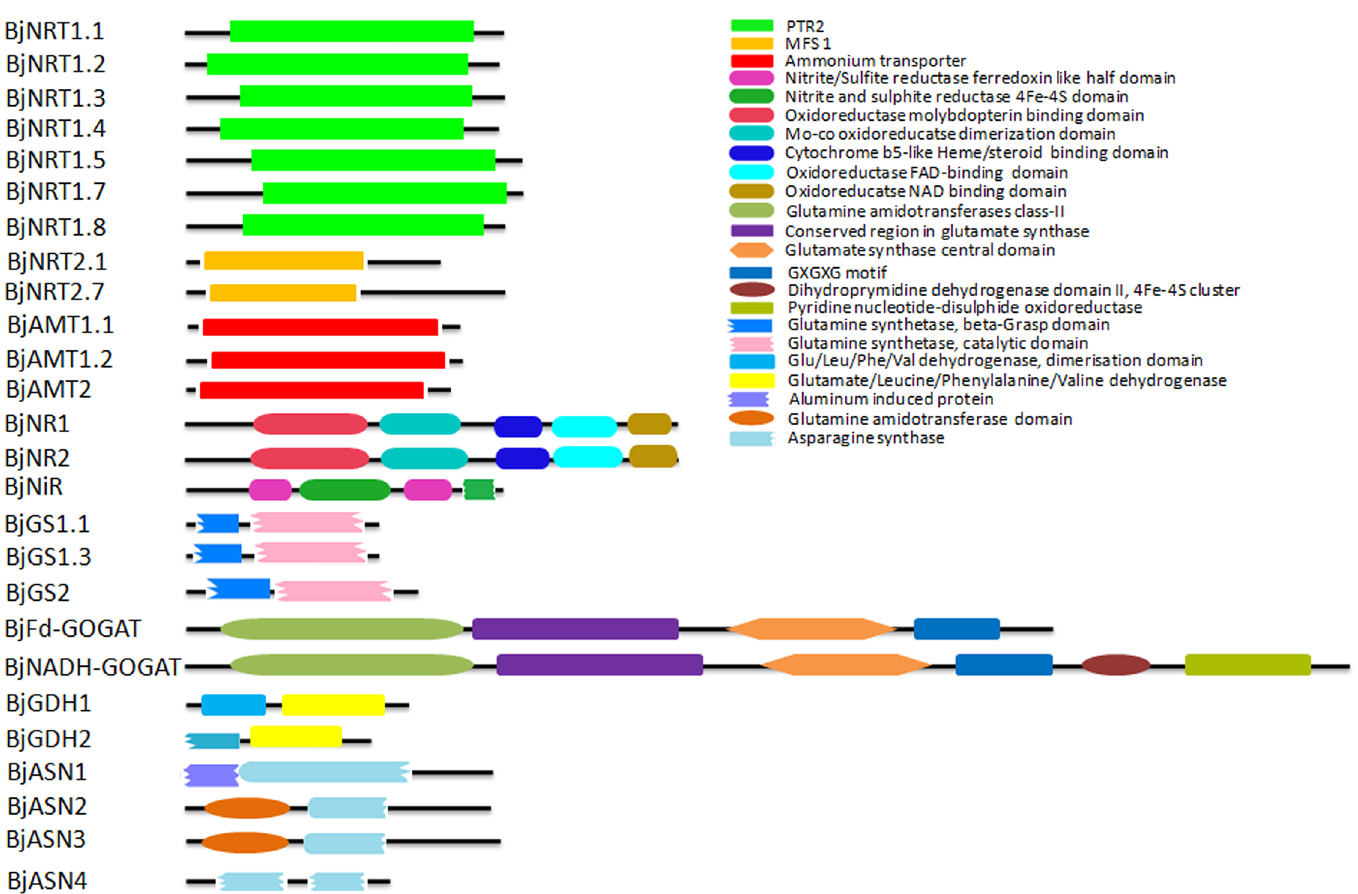
Fig 2. The conserved domain architecture of various proteins involved in nitrate and ammonium uptake, nitrate reduction and ammonia assimilation in B . juncea .